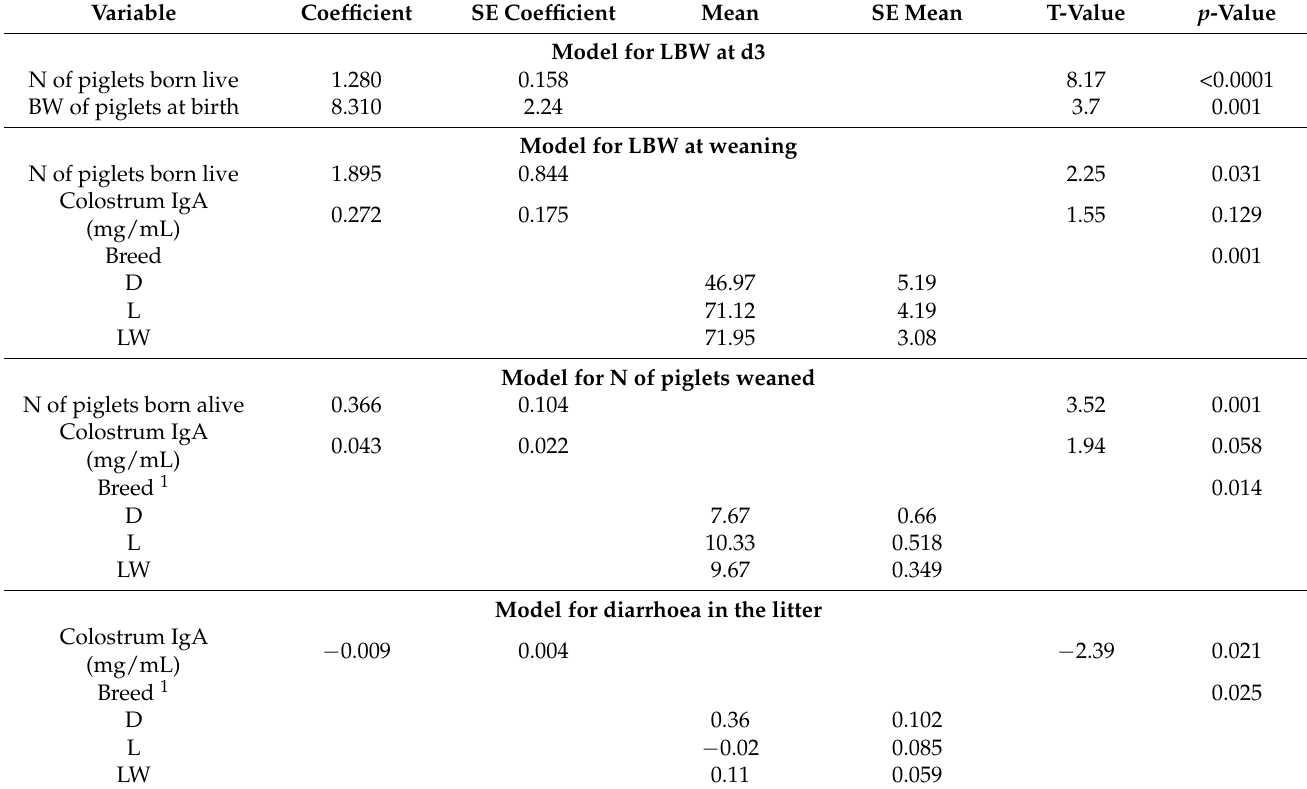
Table 2. Results of the ANOVA analysis on sow performance at three days post farrowing and at weaning.